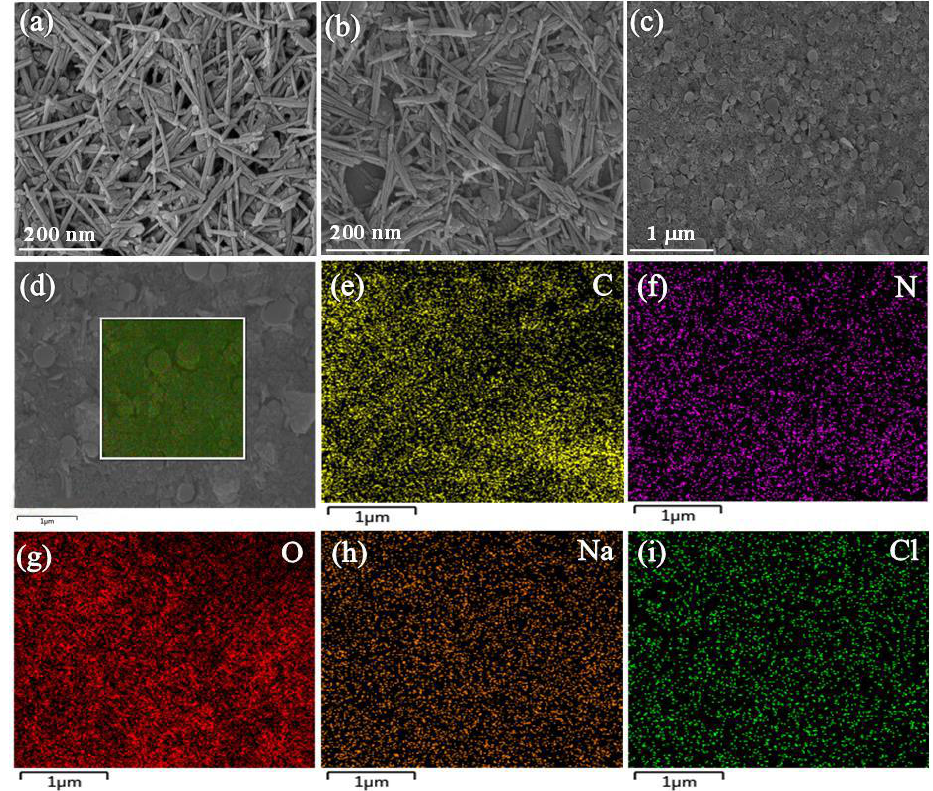
Figure 1. SEM images of ( a ) ATP, ( b ) Na-ATP and ( c ) Na-ATP/DOM; and ( d ) SEM image of selected area of 5%Na-ATP/DOM; and the elemental mapping of ( e ) C, ( f ) N, ( g ) O, ( h ) Na, ( i ) Cl